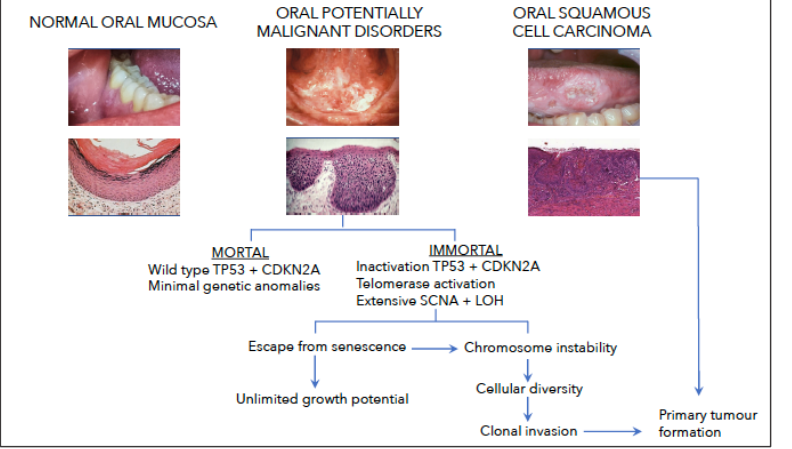
Figure 2. Hypothesis to account for the importance and consequences of genetic instability during the premalignant stage in the development of oral squamous cell carcinoma. The proposal is that during the clinical (normal oral mucosa to OPMD to OSCC) and histological (normal oral mucosa to dysplasia to invasive OSCC) development of oral squamous cell carcinoma, putative cancer cells become progressively immortalised by the inactivation of both TP53 and CDKN2A and the activation of telomerase. The result is that these cells not only have an unlimited growth potential but, also, are able to survive chromosomal breakage leading to the development of aneuploidy and the amplification, deletion and translocation of cancer-relevant genes. Further, aneuploidy leads to the development of cell diversity and the evolution of cell clones that have the capacity to invade the underlying connective tissue and form primary tumours.